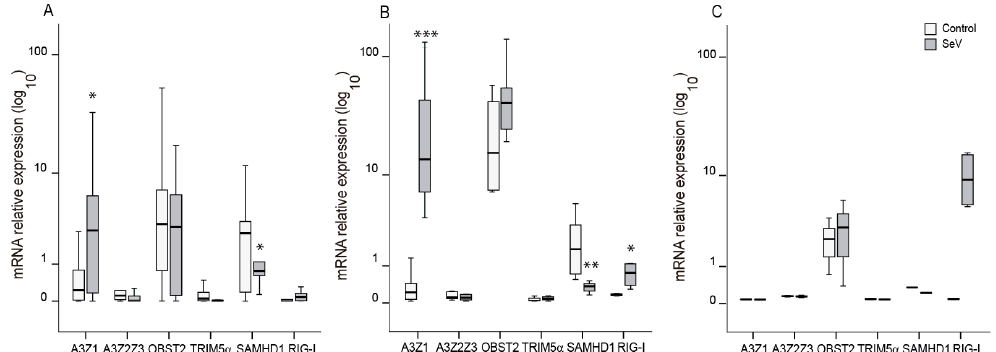
Figure 5. Lentiviral restriction factors mRNA expression in ovine cells after infection with Sendai virus (SeV). Ovine APOBEC3 proteins (A3Z1 and A3Z2Z3), tetherin (OBST2), TRIM5 α , SAMHD1, and RIG-I mRNA expression was quantified in control (white) and SeV-infected (grey) ovine alveolar macrophages ( A ), blood derived macrophages ( B ), and skin fibroblasts ( C ). Values are the median (±interquartile range) of at least three independent experiments, * p < 0.05 , ** p < 0.01, *** p < 0.001 (paired Mann-Whitney U test).